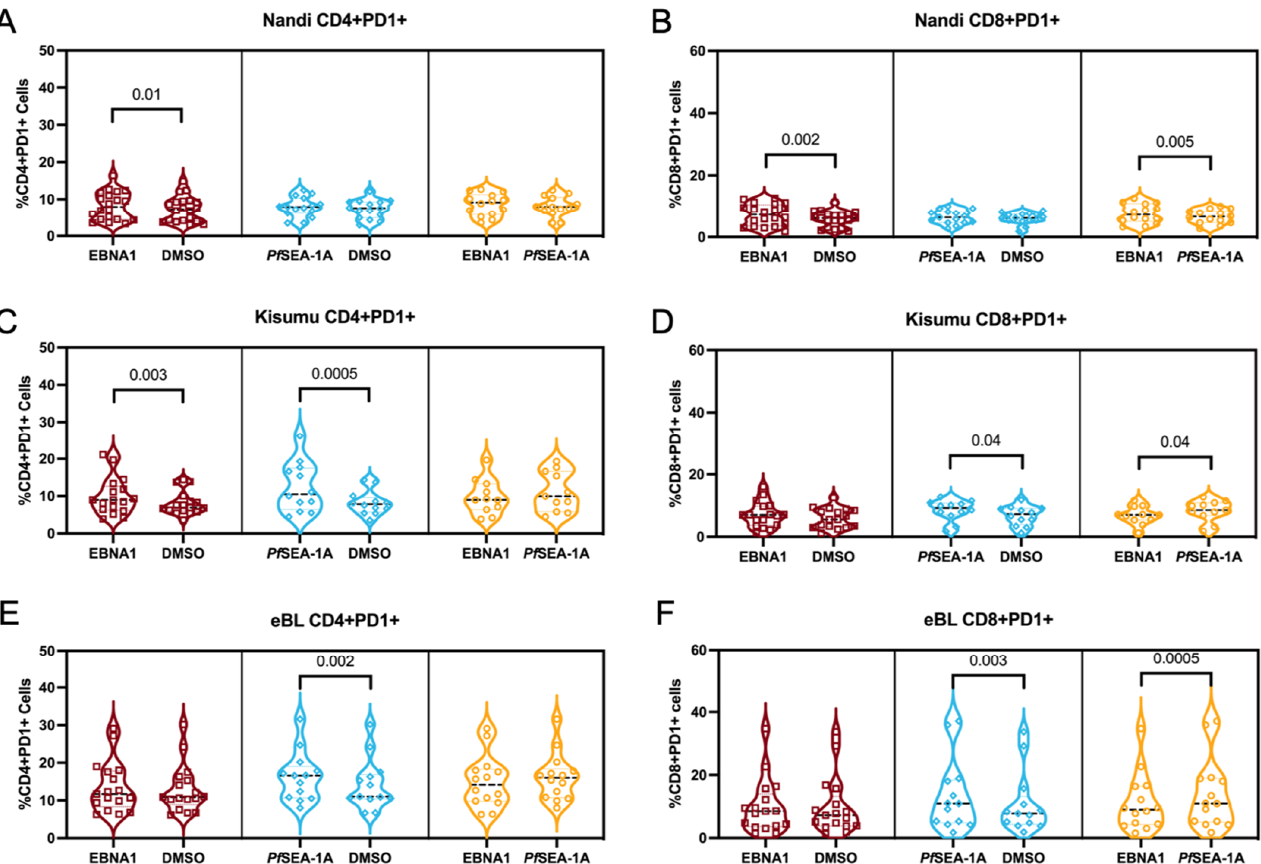
Figure 6. PD-1 expression on stimulated vs. unstimulated CD4 + and CD8 + T cells. Percentage of CD4 + PD-1 + cells from ( A ) Nandi, ( C ) Kisumu and ( E ) eBL children after EBNA1 and Pf SEA-1A stimulation compared to unstimulated, DMSO control. Percentage of CD8 + PD-1 + cells from ( B ) Nandi, ( D ) Kisumu and ( F ) eBL children after EBNA1 and Pf SEA-1A stimulation compared to unstimulated, DMSO control. Wilcoxon two-tailed and matched-pairs test p values are indicated.